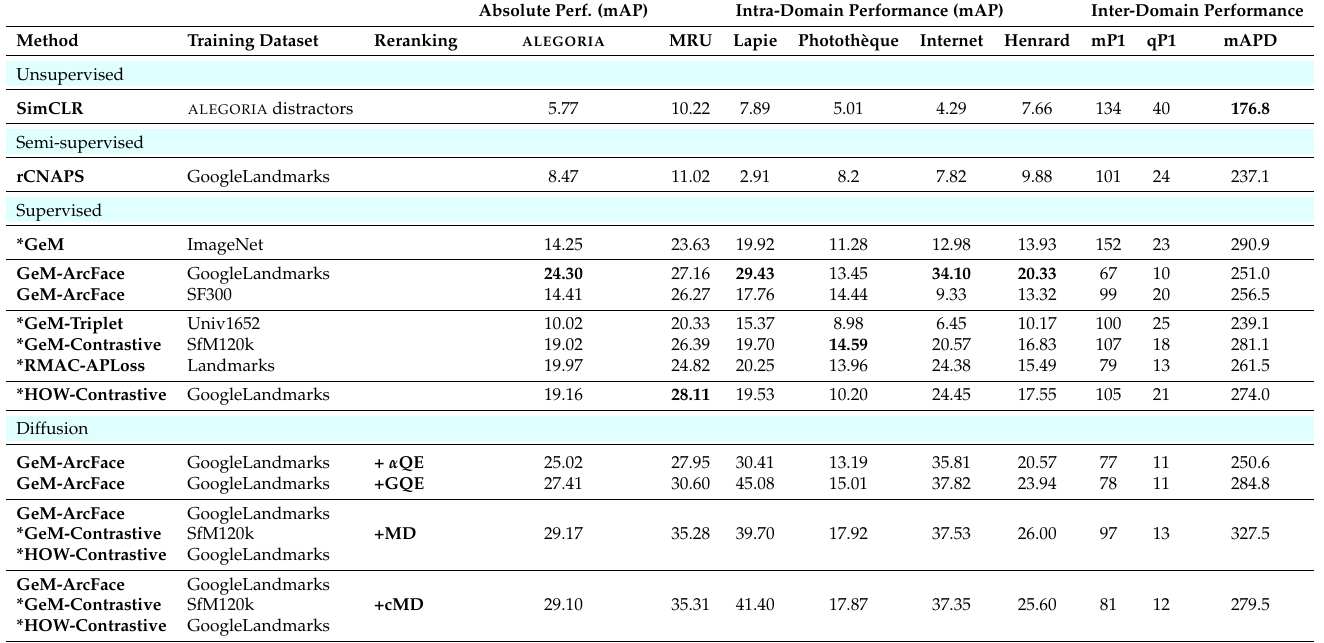
Table 3. Performance comparison of various descriptors on ALEGORIA , with absolute, intra-domain, and inter-domain measures. Descriptors with a star (*) are extracted using authors’ provided model weights; other descriptors are from our own reimplementation and training. Best performance for each measure (column) is in bold . Absolute and intra-domain performance is measured with the mAP (the higher, the better). Inter-domain performance is measured with specific indicators detailed in Section 2.1.3, mP1 and qP1 do not have optimal values, while optimal mAPD is zero (the lower, the better).